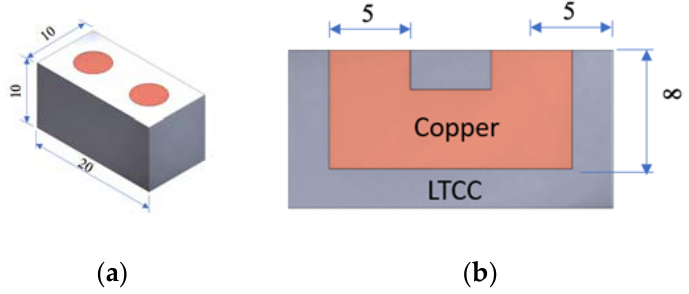
Figure 2. The proposed benchmark LTCC device: ( a ) dimensions and ( b ) cross ‐ section.